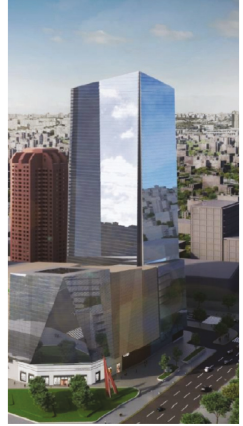
Figure 3: Architectural